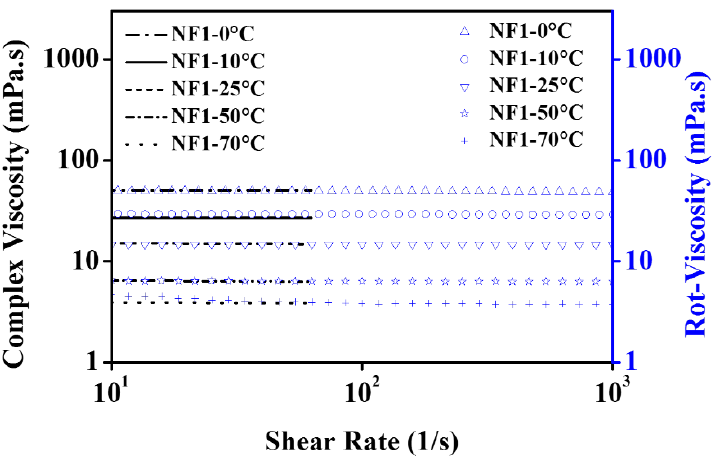
Figure 13. Comparison of complex viscosity and dynamic viscosity from shear flow behavior for NF1. ITT and Hysteresis Loop